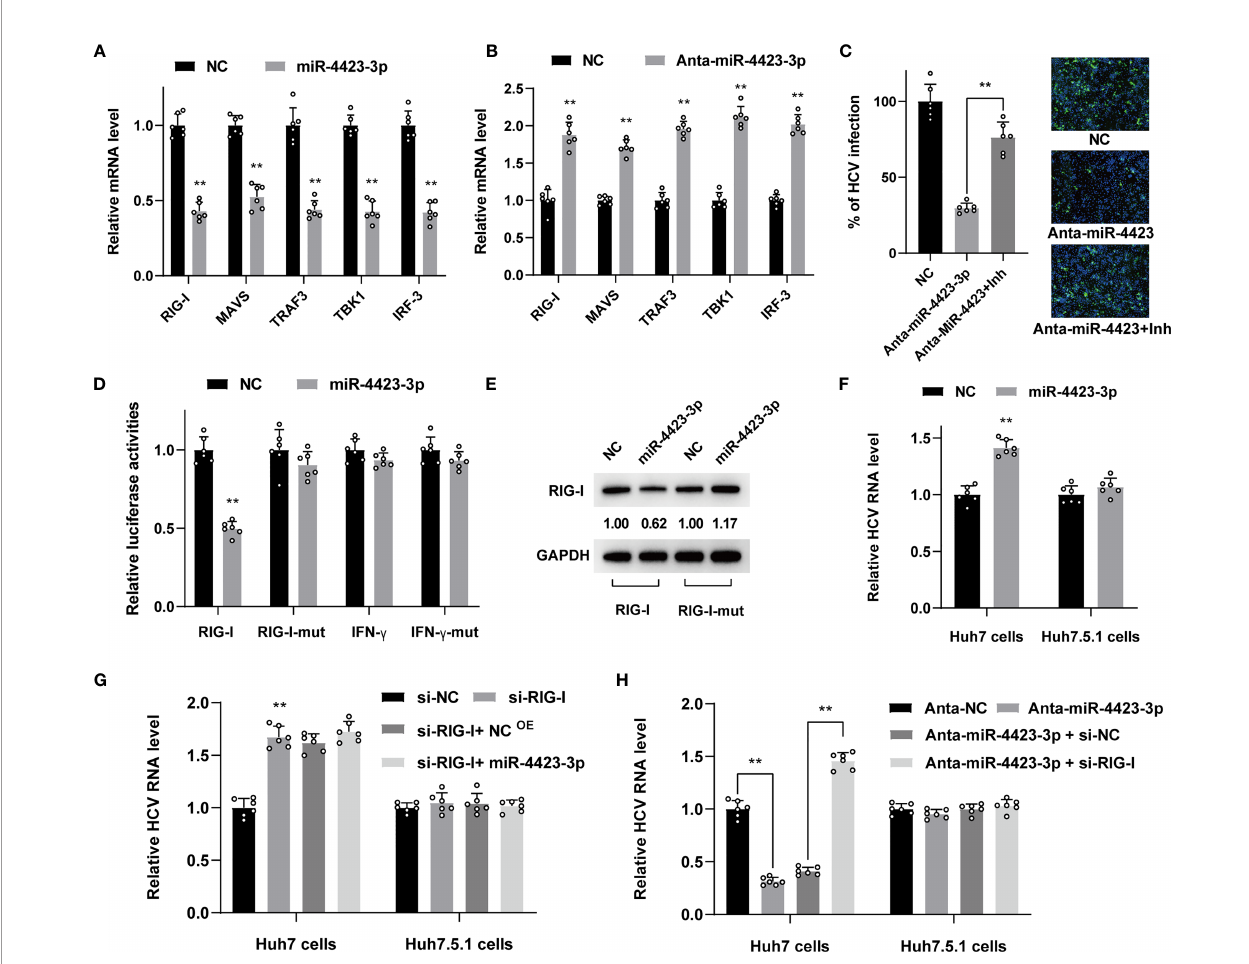
FIGURE 6 | MiR-4423-3p affected viral infection through regulating the expression of RIG-I in Huh7 cells. (A, B) Huh7 cells were transfected with 800 ng/ml miR- 4423-3p mimics (A) or inhibitors (B) together with scramble control and infected with HCVcc (MOI = 0.1). Cells were lysed to test the mRNA level of factor in RIG-I pathway 24 h after infection by RT-qPCR. (C) Huh7 cells were transfected with miR-4423-3p inhibitor (800 ng/ml) or scramble control and infected with HCVcc (MOI = 0.1). Parts of the cells were treated with TBK1 inhibitor of amlexanox. Viral infection was evaluated by IF. **p < 0.01 compared with the group without amlexanox treatment. (D) Dual luciferase reporter assay evaluating the fi re fl y luciferase activities of the plasmids after miR-4423-3p overexpression in Huh7 cells. (E) The protein expression of RIG-I or IFN- g was also tested by western-blot. The images were normalized by GAPDH and quanti fi ed. (F) Huh7 or Huh7.5.1 cells were transfected with 800 ng/ml miR-4423-3p mimics or scramble control, followed by HCV infection (MOI = 0.1), and viral infection was determined by RT-qPCR. (G) RIG-I expression was interfered by relevant siRNA in Huh7 or Huh7.5.1 cells. MiR-4423-3p mimics (800 ng/ml) or scramble control were transfected into the cells subsequently to analyze their effect on HCV infection (MOI = 0.1). (H) Huh7 or Huh7.5.1 cells were treated with MiR-4423-3p inhibitor (800 ng/ml) or scramble control and treated with RIG-I siRNA before the cells were infected by HCVcc (MOI = 0.1). Viral infection was detected by RT-qPCR. Results were shown as relative mRNA or HCV RNA level. **p < 0.01 compared with negative